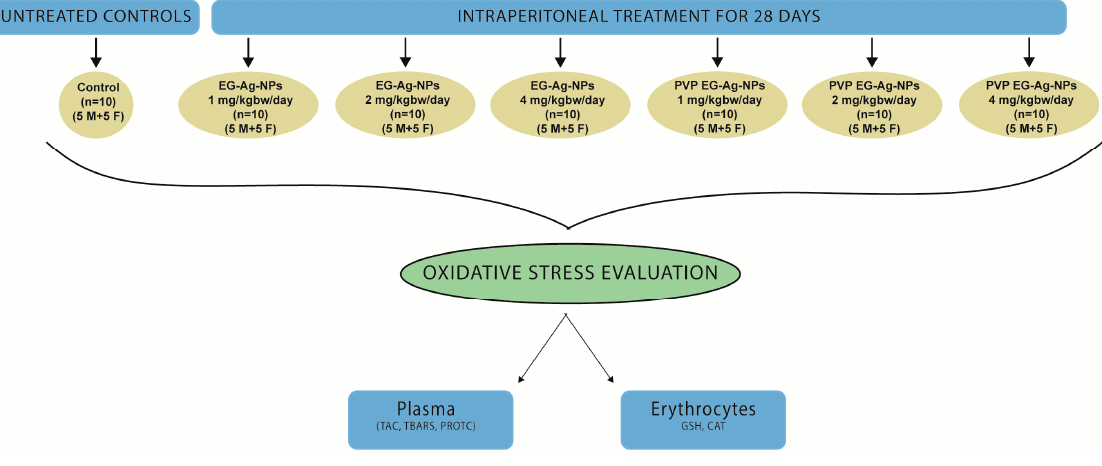
Figure 4. Design of the study.